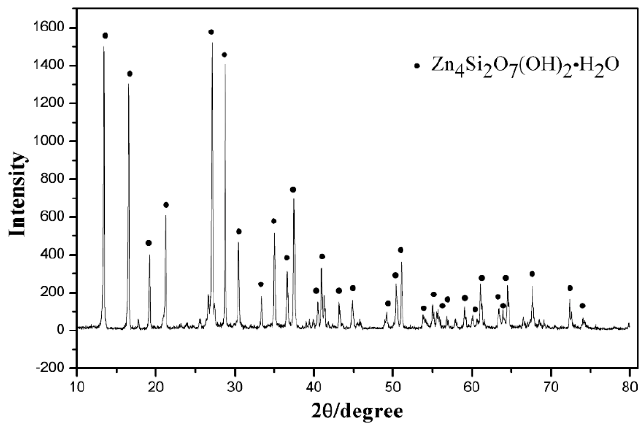
Figure 1. X ‐ ray diffraction (XRD) patterns of the hemimorphite. Figure 1. X-ray diffraction (XRD) patterns of the hemimorphite. Table 1. Mineralogical analysis of hemimorphite. Table 1. Mineralogical analysis of